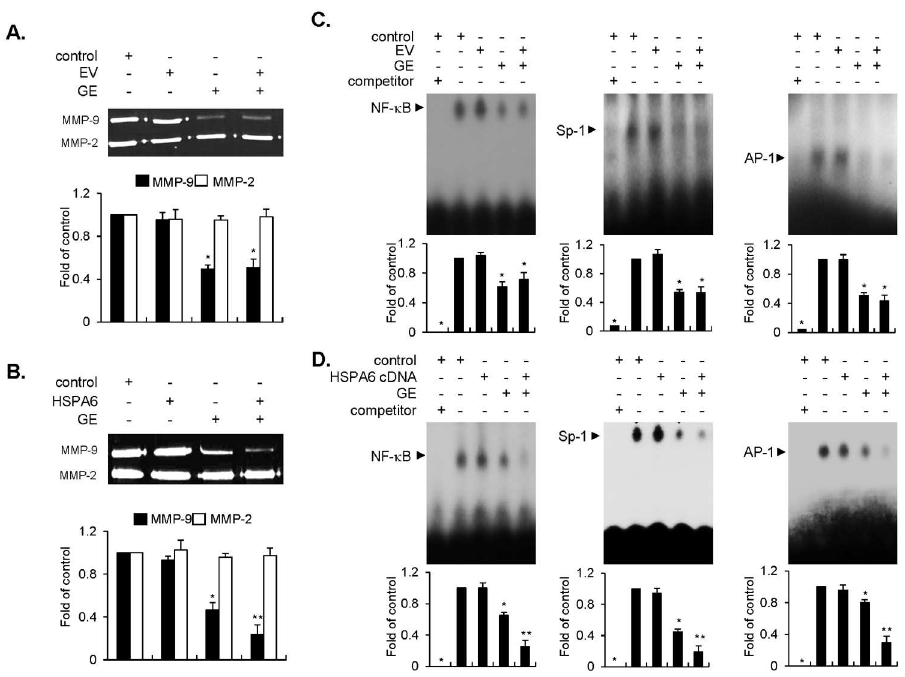
Fig 7. HSPA6 intensified GE-mediated inhibitory effect of MMP-9 activity via suppression of binding activity of AP-1, Sp-1, and NF- κ Bin EJ cells. EJ cells were transfected with an EV (A, C) or HSPA6 (B, D) followedby incubation either in the presenceor absenceof GE. (A, B) Proteolytic activity of MMP-9 was assessedby gelatin zymography. (C, D) EMSA was performed to detect the bindingactivity of AP-1, Sp-1, and NF- κ B using radiolabeled oligonucleotide probes. UnlabeledAP-1, Sp-1, and NF- κ B oligonucleotides were used as competitors. Relativefold changeswere indicatedto compareagainstthe control versus GE treatment. In each bar graph, results are presented as the mean ± SE from three different triplicate experiments. * P < 0.05, compared with the control and ** P < 0.05, comparedwith GE